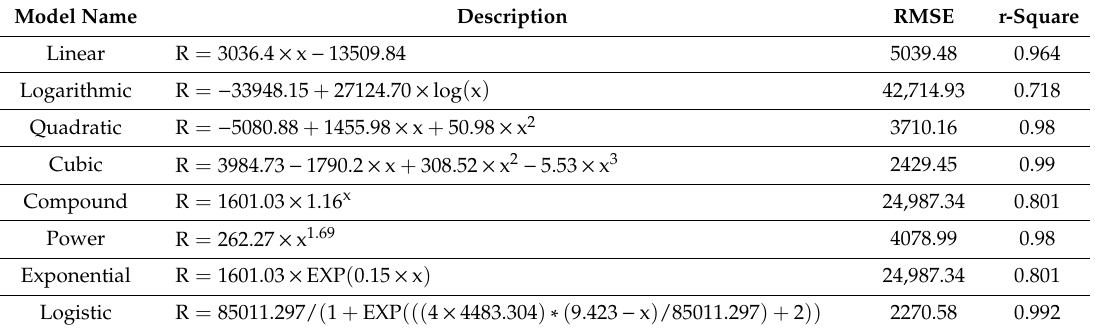
Table 11. Model description for China fitted by GWO.